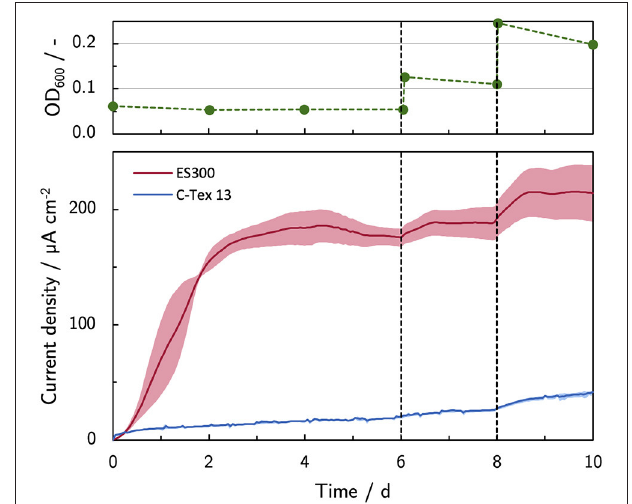
FIGURE 4 | Current production with inoculum spikes on day 6 and 8. The current density is evaluated before each inoculum spike on day 6 and 8, and at the end of the experiment on day 10. The shaded area corresponds to the sample standard deviation of three anodes. The numerical values can be found in Supplementary Table 4 .